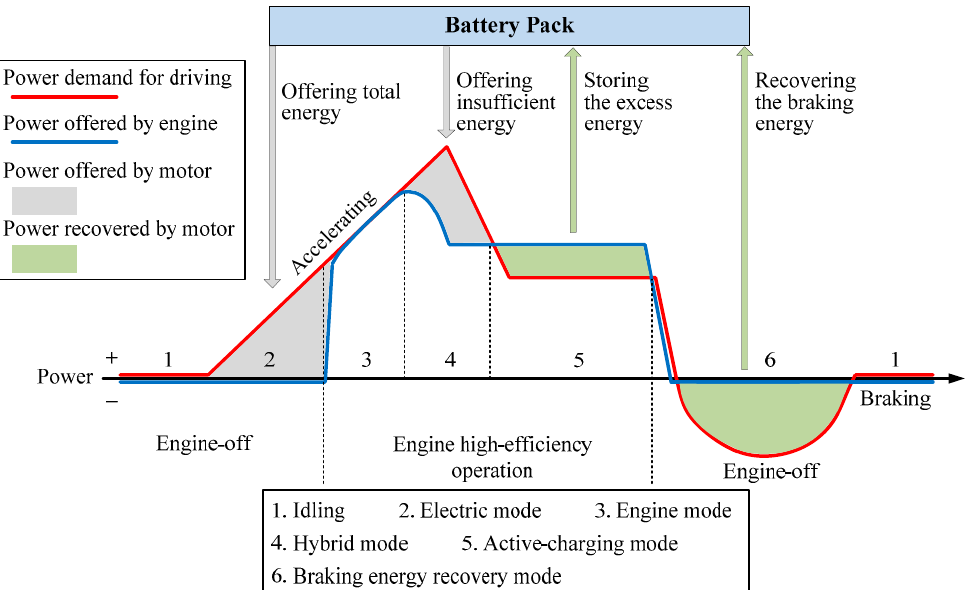
Figure 2. Working modes of the plug-in hybrid electric vehicle (PHEV).